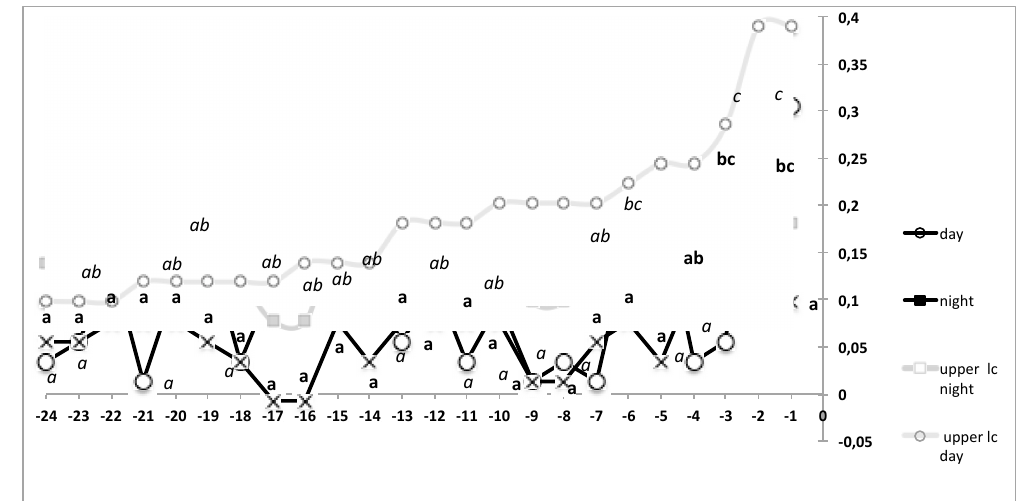
Figure 1. Least square means and upper 95% confidence limits of posture changes for cows that calved at night and by day. On the x-axis: hour relative to delivery; on the y-axis: hourly proportion of records ( n /12). Different letters indicate differences ( p < 0.005) between the least square means (LSM) within groups. Groups: cows that calved at night ( bold) or during the day ( italic). Cows that calved at night differed ( p < 0.05) from those that calved during the day only at − 17 h, − 16 h, − 3 h, and − 1 h relative to delivery. For both groups, two h before delivery, the proportion of records at which posture changes were observed was higher than each proportion calculated from − 24 to − 6 h relative to delivery ( p < 0.005). On average, the posture changes counted at 2 h relative to delivery were 3.6 times the average of the previous h relative to delivery. Cows that calved at night walked more than cows that calved during the day ( p = 0.0112), but there was an interaction with hour relative to delivery. Figure 2 shows the LSM for walking (root arcsin of proportion of total records).